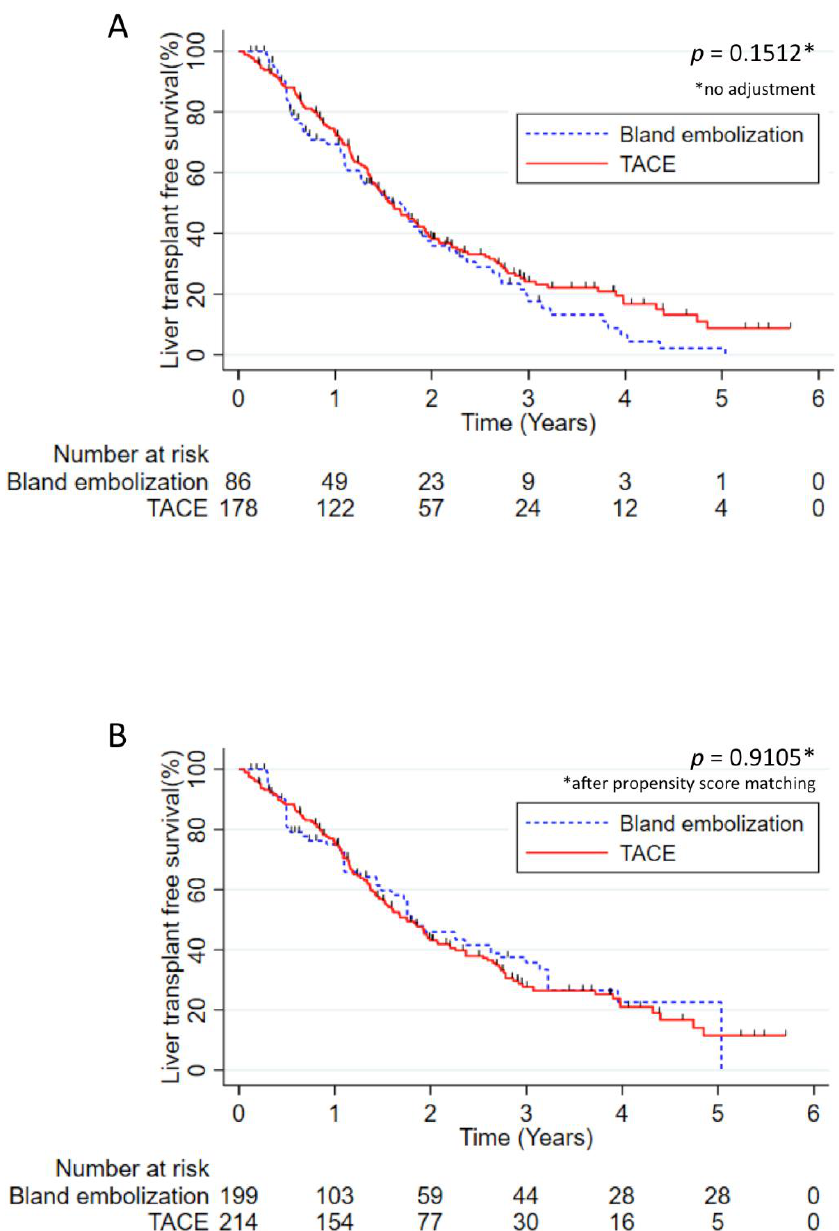
Figure 4. Liver transplantation-free survival in patients treated by TACE versus patients treated by TAE. ( A ) Liver transplantation-free survival without adjustment and ( B ) liver transplantation-free survival adjusted using the propensity score in patients treated by TACE versus patients treated by TAE. The results were analyzed using the Kaplan – Meier method and compared using the log rank test. Numbers at risk were reported under the x -axis.